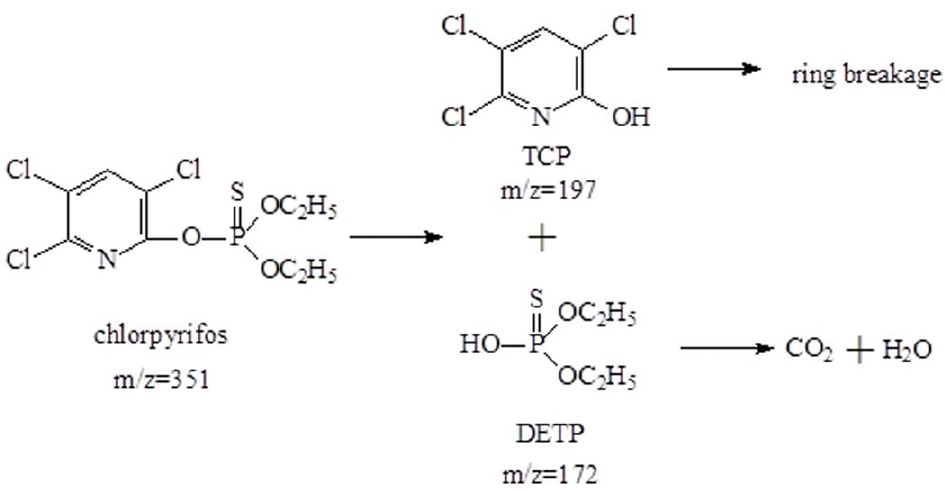
Figure 5. The proposed pathway for the chlorpyrifos degradation by strain Hu-01.